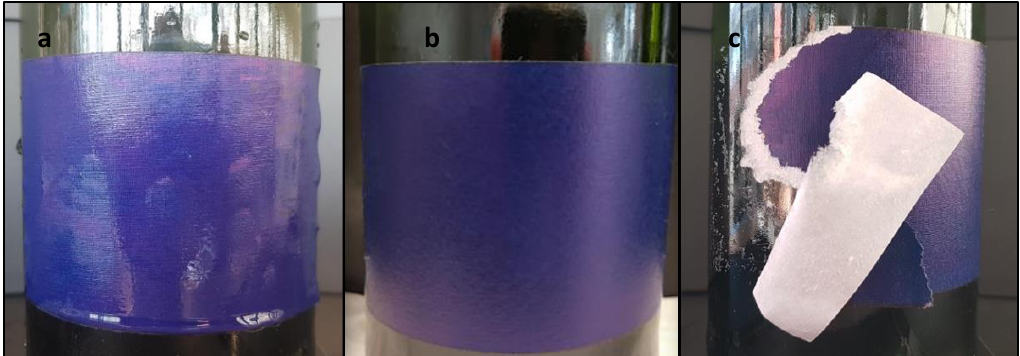
Figure 12. Optical pictures of the di ff erent states of a label of a same bottle using the adhesive E100 in the ice bucket test: ( a ) label just after remove the bottle from the ice bucket, ( b ) dried label after 24 h to remove the bottle from the ice bucket and ( c ) structural failure upon peel o ff the label